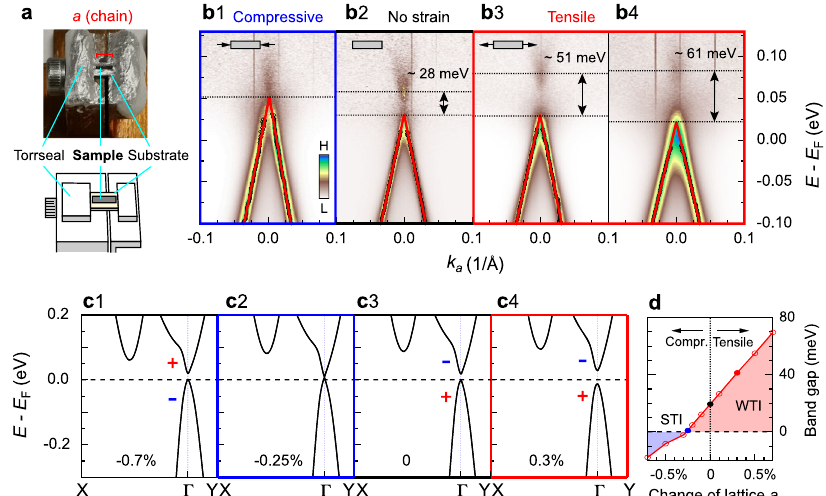
Fig. 3 Control of the topological phase by external strain. a The strain device. A screw is used to compress or stretch the substrate (and thus the sample attached to it) along the chain direction of the samples. The red line indicates the chain direction. b Bulk band gap change with compressive and tensile strain. With compressive strain (b1), the gap is (nearly) closed, reaching a Dirac semimetal state. With tensile strain (b3 – b4), the band gap becomes larger, stabilizing the WTI state. The data are taken with p -polarized photons and normalized by their density of states (DOS). The black markers are extracted from the MDC peaks, and the red solid lines are the fi tting results of the black markers, same as the ones in Fig. 1h. c Calculations on the band structure with different lattice constant a . + and − signs indicate the parity of the two bands. b , c The blue (red) frames correspond to compressive (tensile) strain. d Calculated phase diagram with different lattice constant (strain). Blue, black, and red solid markers roughly indicate the experimental values in b .